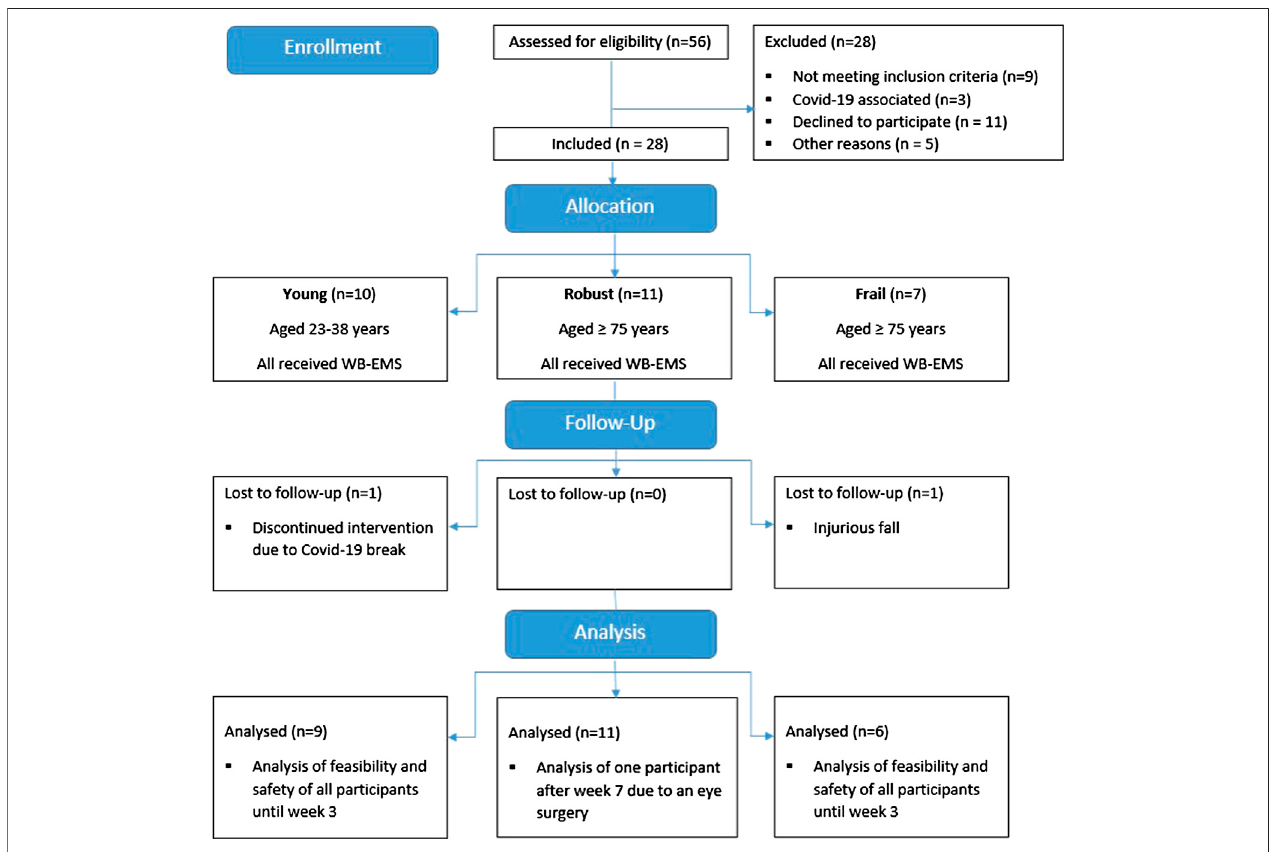
FIGURE 2 | Diagram of participant fl